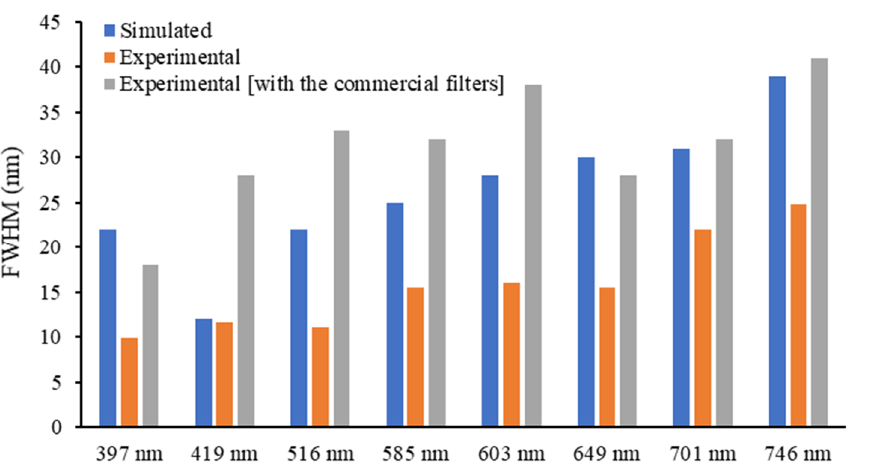
Figure 9. Comparison between the numerical simulated and experimental ( n = 3) FWHM (nm) for each of the 8 MgO/TiO 2 and SiO 2 /TiO 2 optical filters.